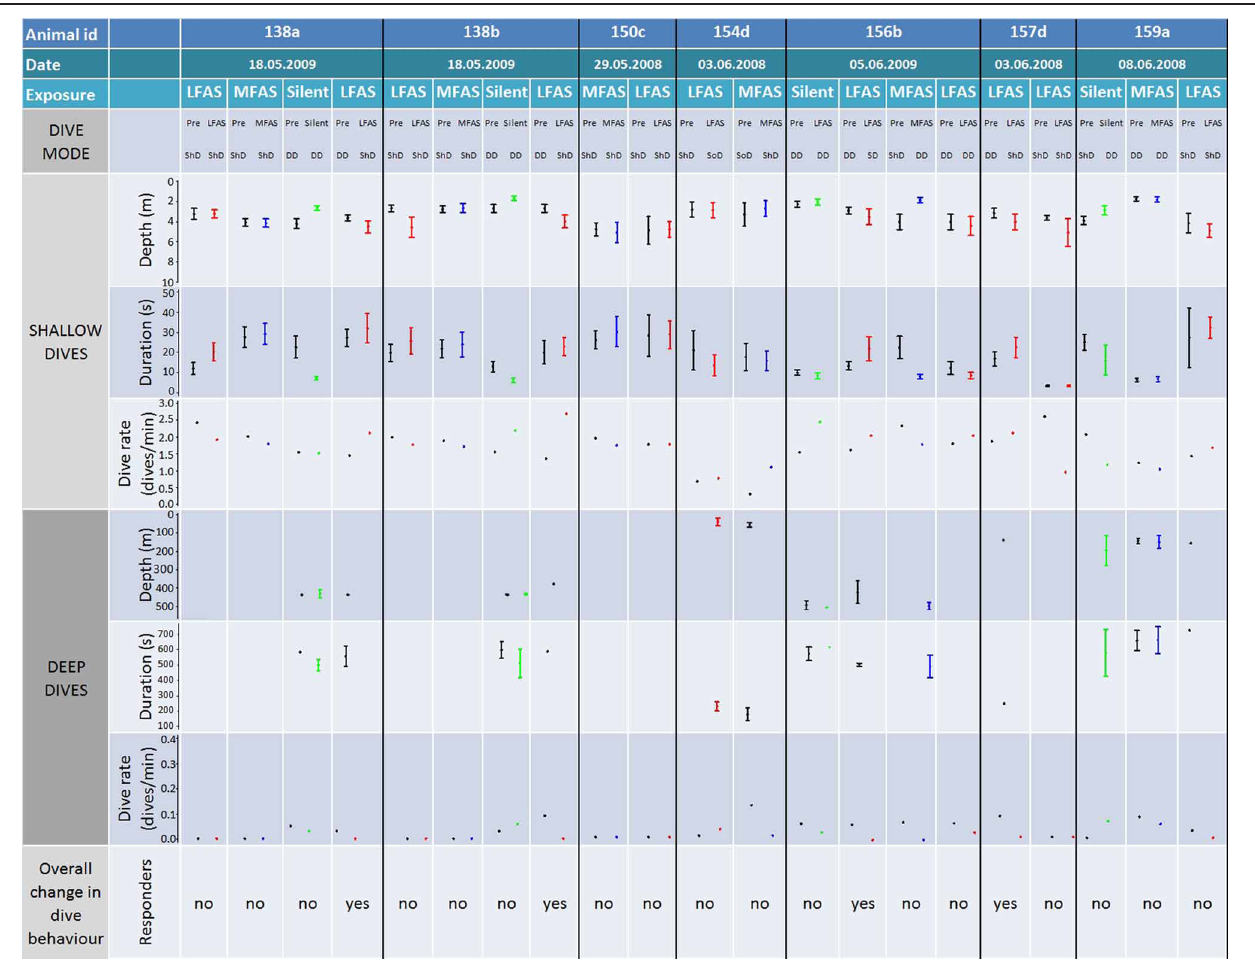
deep dive (SoD). Bars show the 95% confidence interval. Dive rate for deep and shallow dives are number of dives in the PRE/Exposure period divided on the duration of the period, given as dives pr min. All individual exposure sessions are classified either as a “responder” or not, based on the combined comparison of the depth, duration rate, and mode of the PRE and Exposure